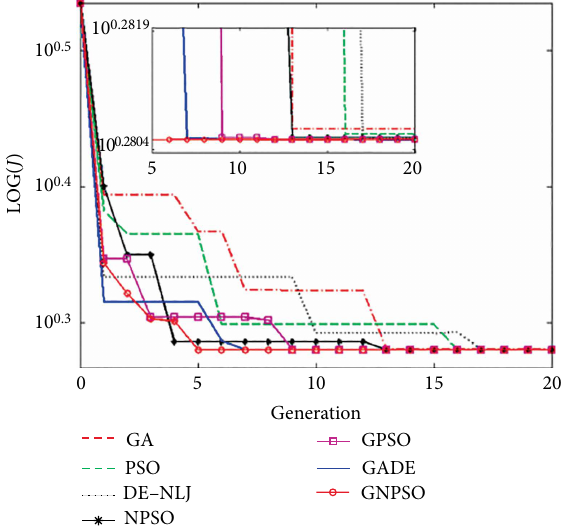
𝐹 𝑚𝑖𝑛 obtained by GA, PSO, NPSO, GPSO, DE–NLJ, GADE and GNPSO